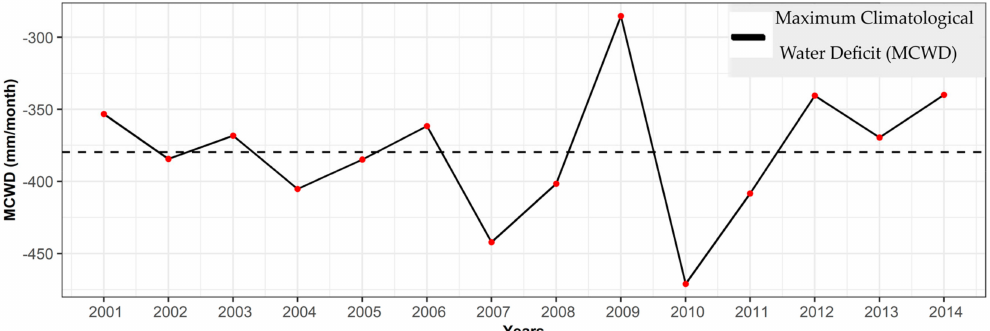
Figure 1. Variation in the drought index (maximum climatological water deficit (MCWD)) between 2001 and 2014. The dotted line represents the historical